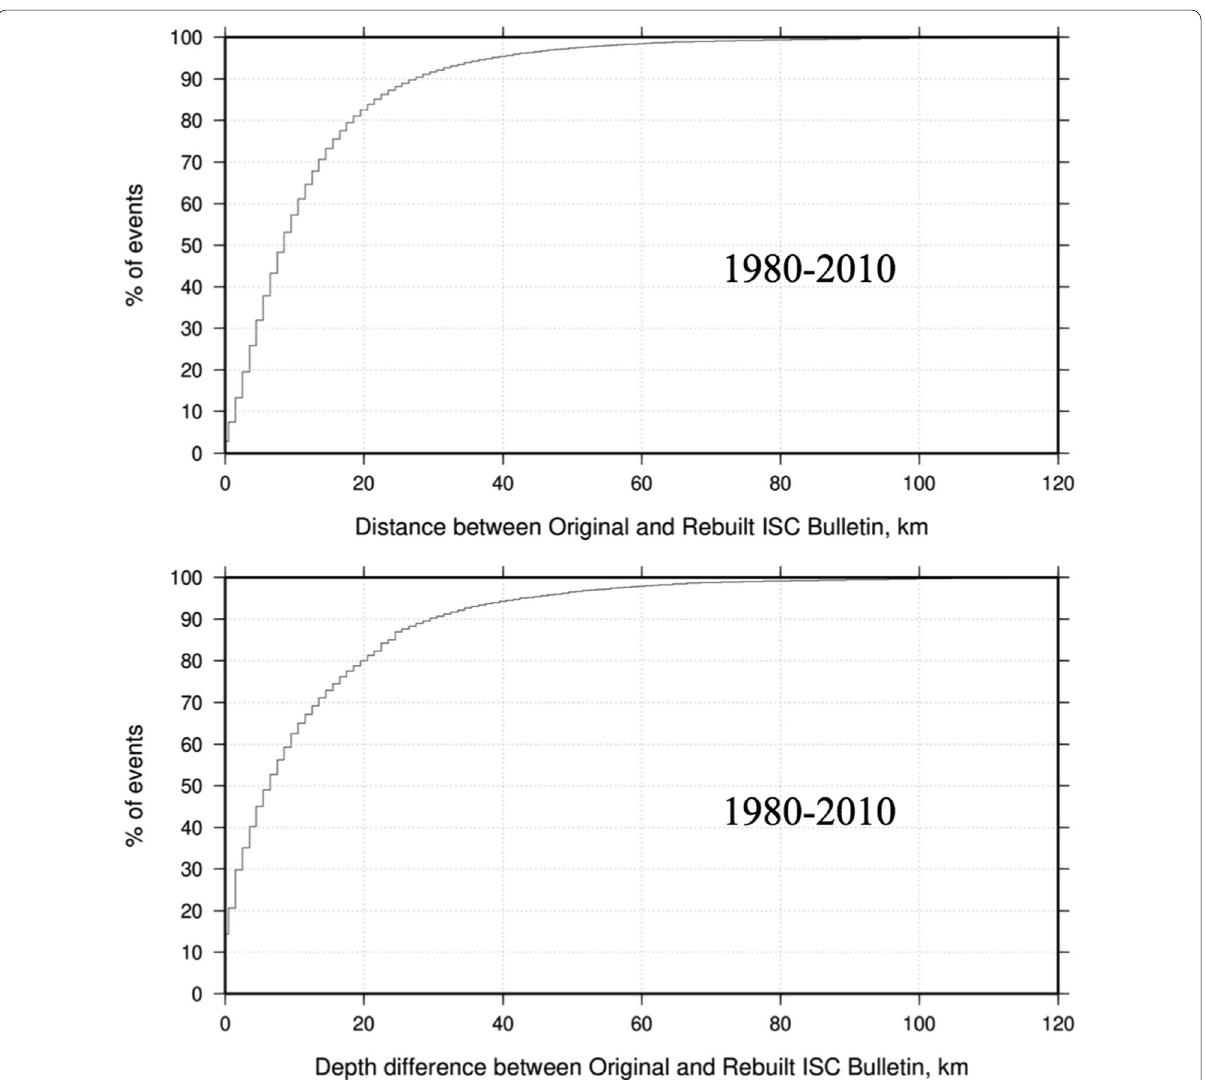
Fig. 5 Cumulative statistics of departures in location and depth of origin between matching events in the original and rebuilt ISC